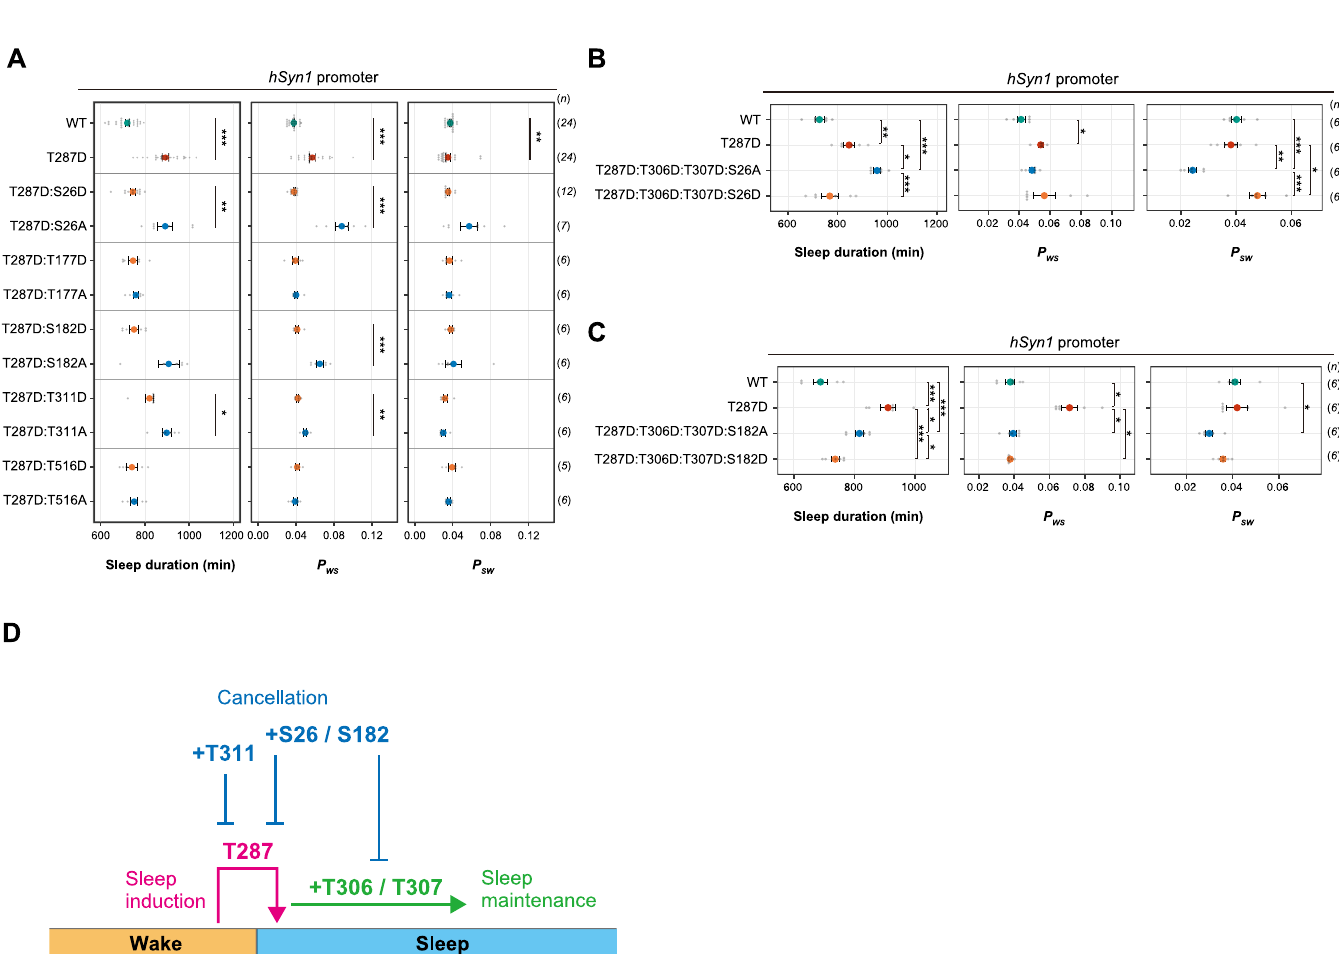
Fig 6. Multisite phosphorylation of CaMKII β can control sleep induction, maintenance, and cancellation of sleep induction/maintenance. (A) Sleep/wake parameters, averaged over 6 days, of mice expressing CaMKII β mutants with D or A substitutions of residues that cancel the sleep-inducing effect of T287D in Fig 5A. Measurements are independent from those in Fig 5A. (B, C) Sleep/wake parameters of mice expressing quadruple-phosphomimetic CaMKII β mutants related to S26 (B) and S182 (C) . Multiple comparison tests were performed between all individual groups. Error bars: SEM, � p < 0.05, �� p < 0.01, ��� p < 0.001. (D) Ordered multisite phosphorylation states of CaMKII β in sleep regulation. T287-phosphorylated CaMKII β induces sleep from wakefulness (sleep induction). Additional phosphorylation at T306 and T307 converts the sleep induction activity to the sleep maintenance activity. These sleep induction and maintenance activities are cancelled by the additional phosphorylation at S26, S182, and T311 (T311 seems to work only for cancellation of sleep induction, not for sleep maintenance). Note that this model only describes about the possible relationship between CaMKII β and the sleep–wake cycle without considering the difference between NREM and REM sleeps. The underlying data can be found in S1 Data. See also S12 Fig. CaMKII β , calmodulin-dependent protein kinase II β ; NREM, nonrapid eye movement; REM, rapid eye movement.